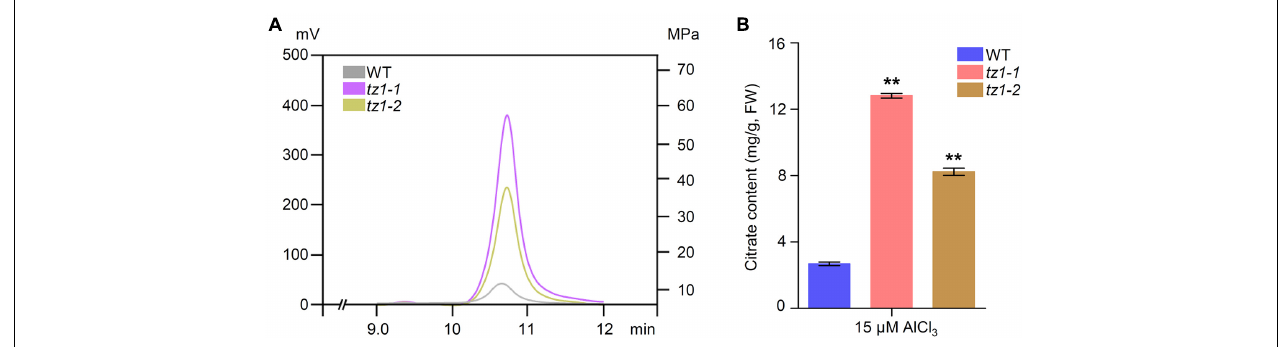
FIGURE 6 | Citric acid content in tz1. (A) The citrate content in the roots were determined by high performance liquid chromatography (HPLC). The 7-day old seedings of WT and aco exposed to 15 µ M AlCl 3 for 24 h before measurement. (B) Quantification of the Al-induced citrate content in the WT and tz1 mutants. ** p < 0.01 (Student’s t -test).